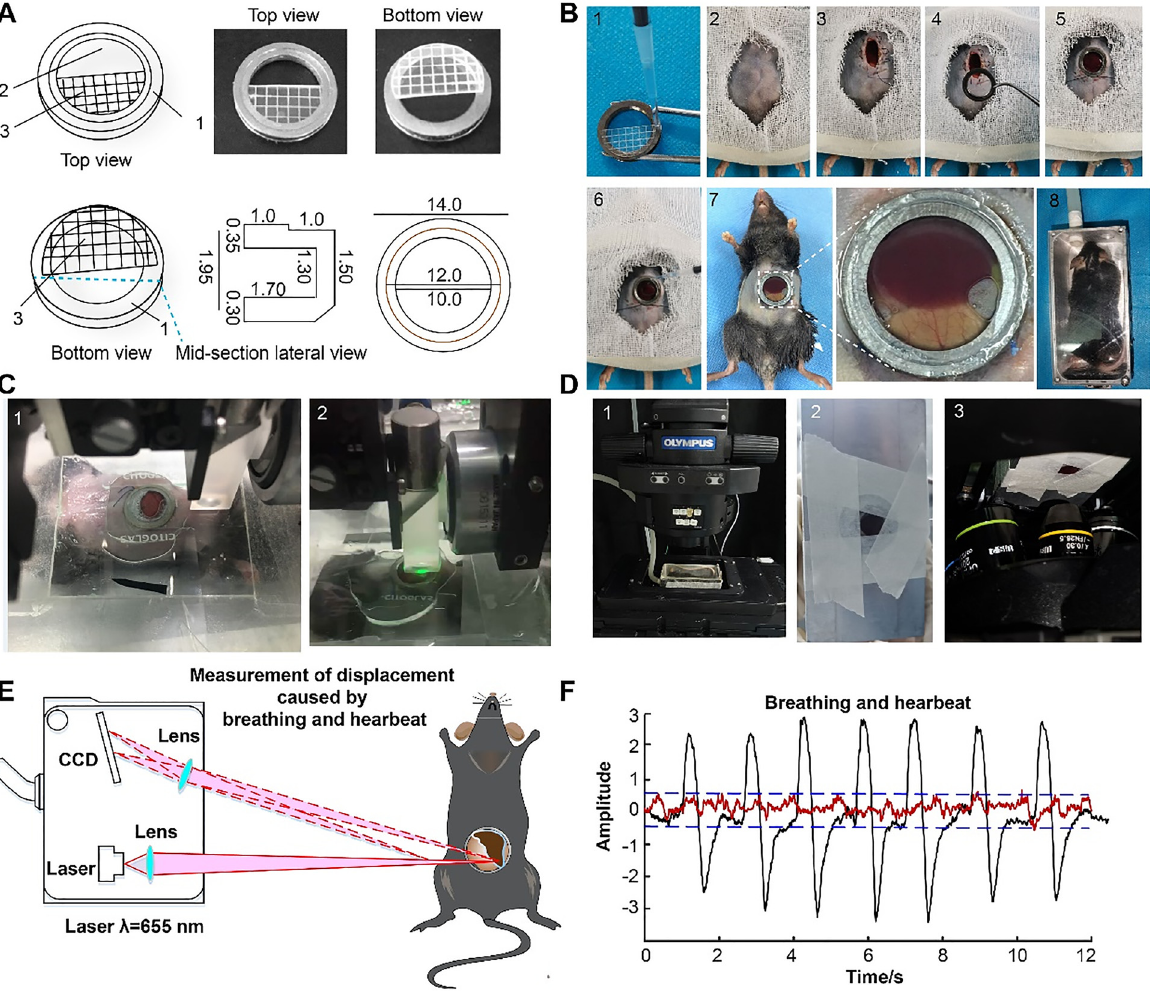
Figure 1: DAWarc design, surgical procedure, and liver jitter amplitude detection. (A) DAWarcwindowframedesign.All dimensionsare inmillimeters.(B)Overviewof thesurgicalprocedure.(C) Photoacousticimagingofmice with the DAWarc using an upright photoacoustic imaging system. (D) Fluorescence imaging of the same mice using an inverted confocal imaging system. (E) Schematic diagram of the detection of respiratory jitters in mice with the DAWarc or standard AIW using a laser displacement sensor, the laser wavelength was 655 nm. (F) Comparing amplitude curves of the respiratory jitters of mice with different windows: the black curve represents the respiratory jitters of mice using the standardAIW, and the red curve denotesthe respiratory jitters of mice using the DAWarc. The quantitative unit of amplitude is millimeter